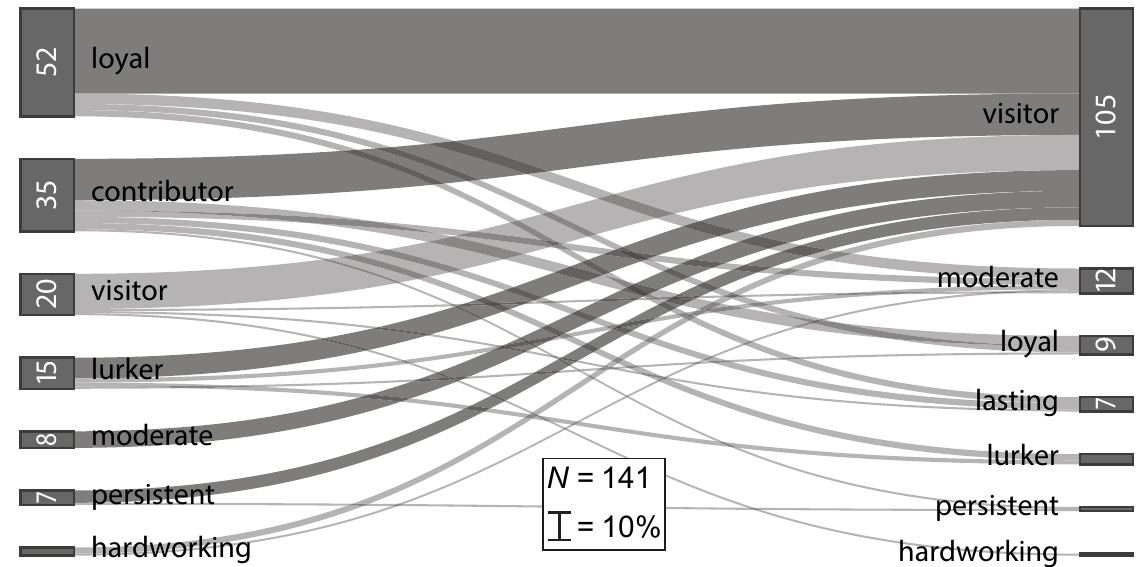
Fig 3. Sankey diagram of participants’ transitions. Transitions occur between engagement profiles ( N = 141; ‘Wildlife Researchers 1’) between the data collection (left) and the data analysis phase (right), with all p s < .05 (dark grey) [Interactive version online in S3 File].